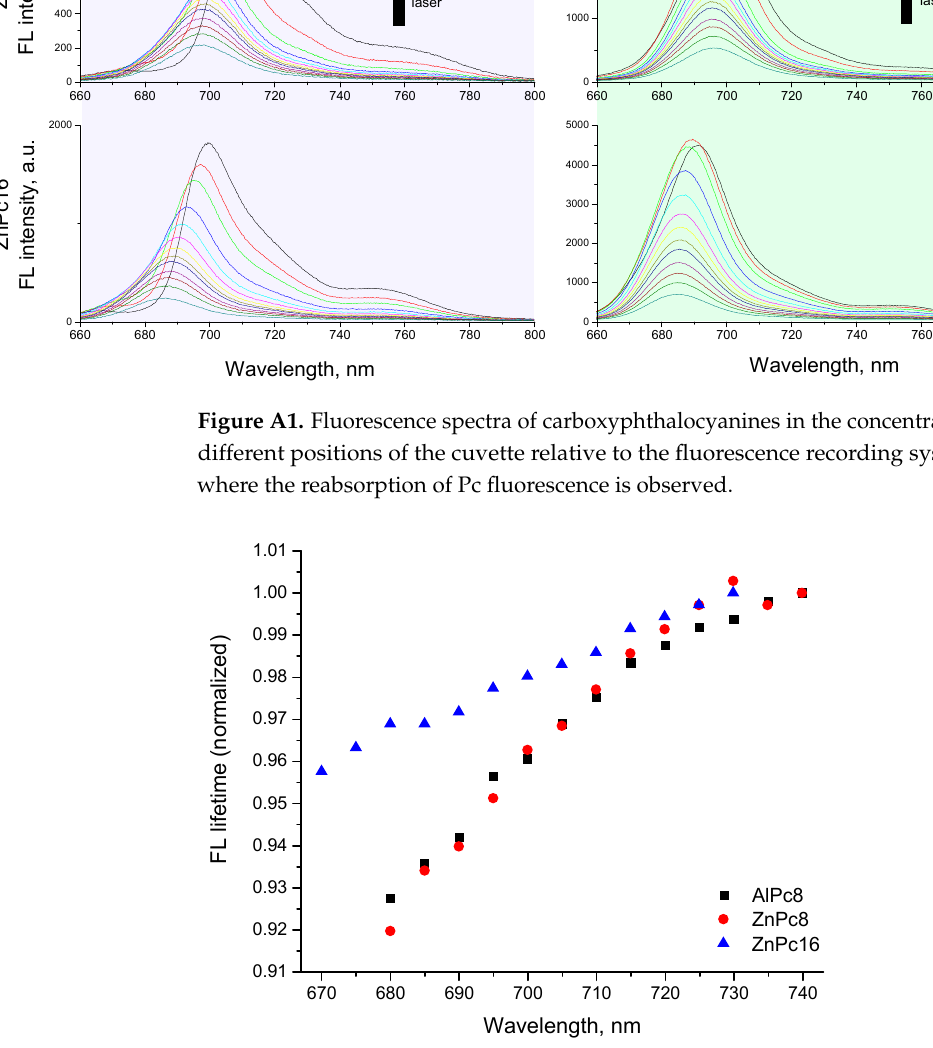
Figure A2. The fluorescence lifetime of carboxyphthalocyanines in 1 mM aqueous solution, normal- ized to the value of the lifetime τ 0 in a dilute solution. The τ 0 is independent on wavelength of the fluorescence detection. Fluorescence excitation wavelength is 655